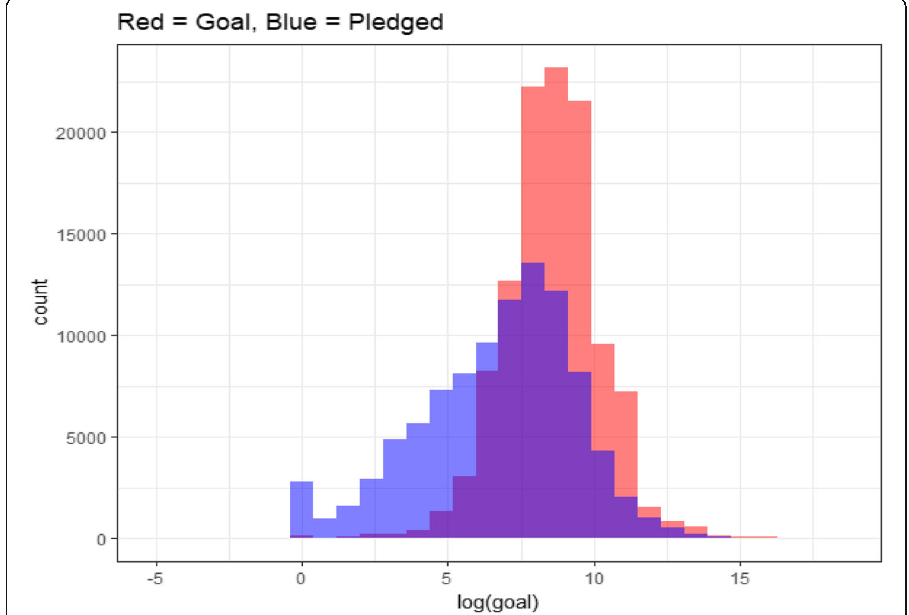
Fig. 4 Histograms of goal (red) versus pledge